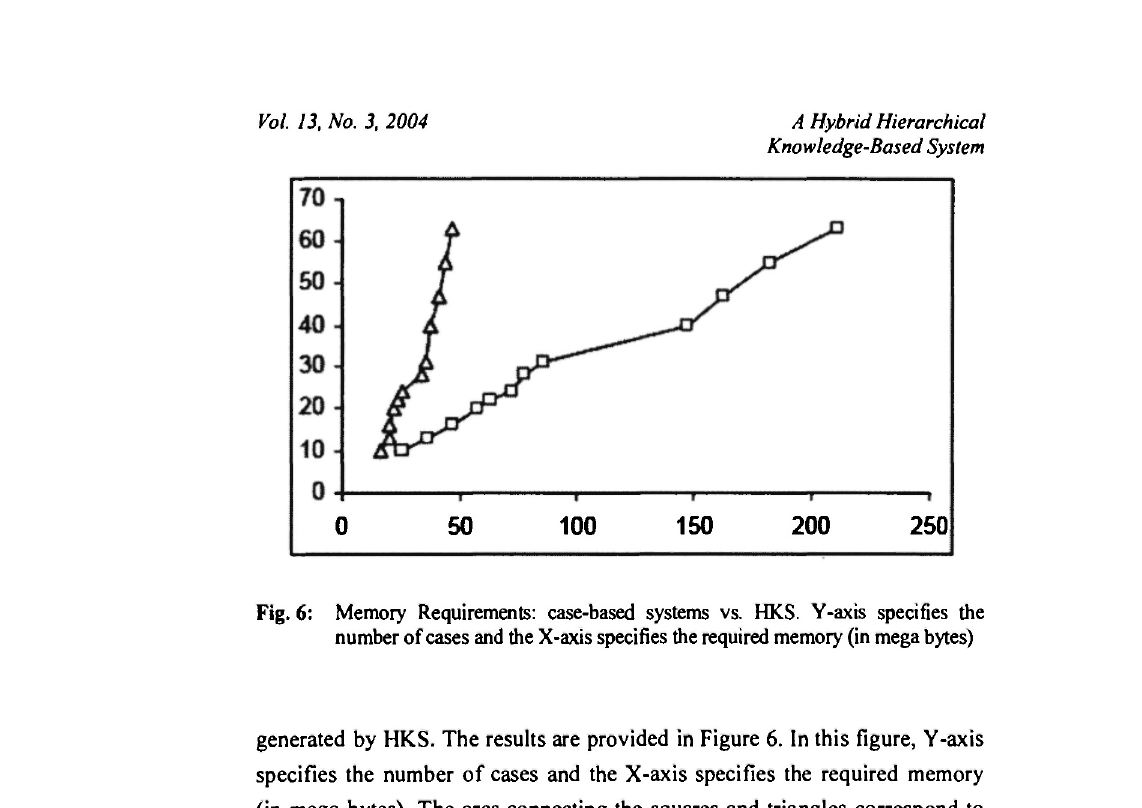
Fig. 6: Memory Requirements: case-based systems vs. HKS. Y-axis specifies the number of cases and the X-axis specifies the required memory (in mega